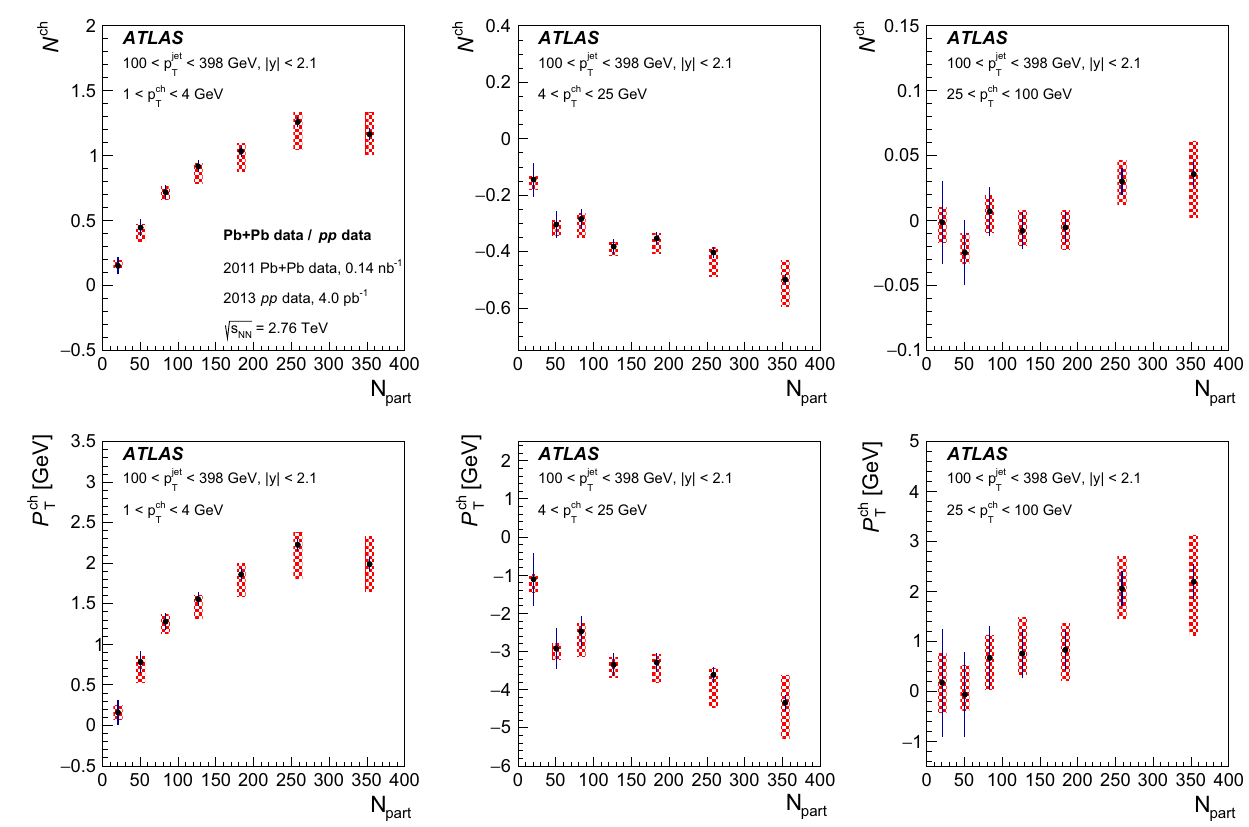
Fig. 8 ( Upper panels ) The difference N ch between the total yield of suredinPb+Pbcollisionsandthetotaltransversemomentumofparticles particles in a given p ch measured in pp collisions. The differences were evaluated as a function interval (indicated in the legend) measured in T of number of participating nucleons, N part . The error bars on the data Pb+Pb collisions and the total yield of particles in the same p ch interval T points indicate statistical uncertainties while the shaded bands indicate measured in pp collisions. ( Lower panels ) The difference P ch between T systematic uncertainties the total transverse momentum of particles in a given p ch interval mea- T Table 1 The difference between pp and Pb+Pb collisions in the total range of charged-particle transverse momenta, 1 < p ch momentum, P ch and for different values of , and the total difference in the yield of charged par- T ticles between pp and Pb+Pb collisions, N ch , evaluated over the full